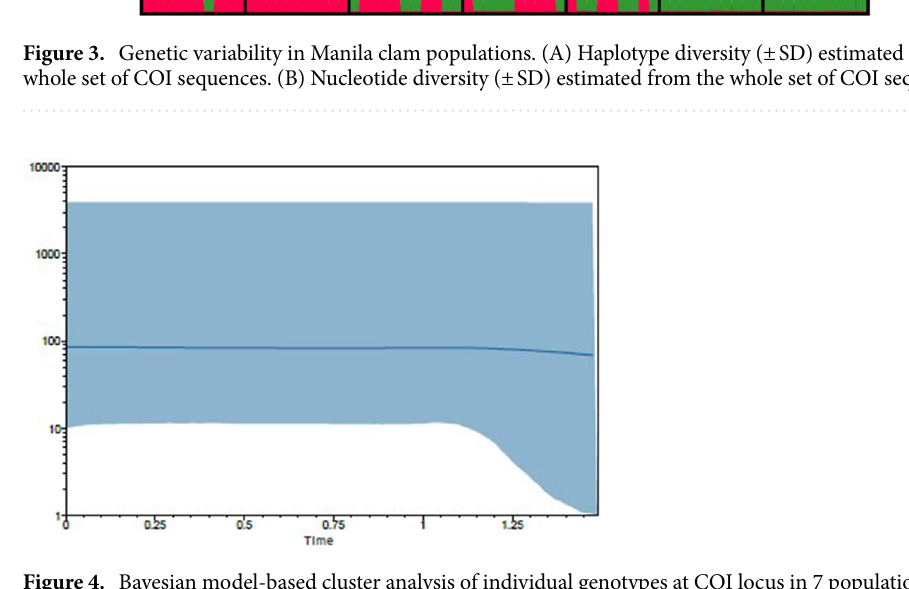
Figure 4. Bayesian model-based cluster analysis of individual genotypes at COI locus in 7 populations of Manila clam. Estimated membership fractions for each individual and population are shown for K = 2, K = 3 and K = 4 clusters. Cluster1 (Red), Cluster2 (Green), Cluster 3